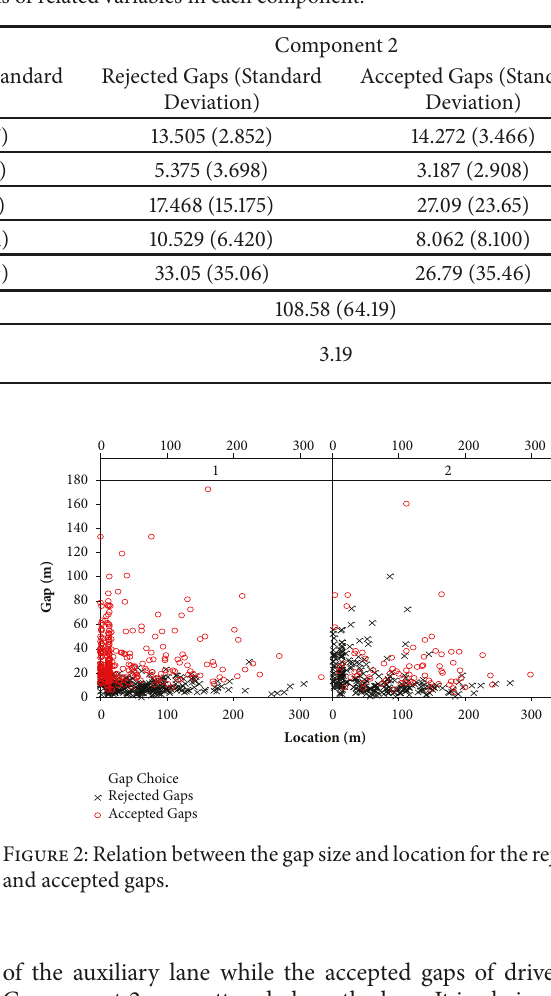
Table 6: Mean values and standard deviations of related variables in each component.